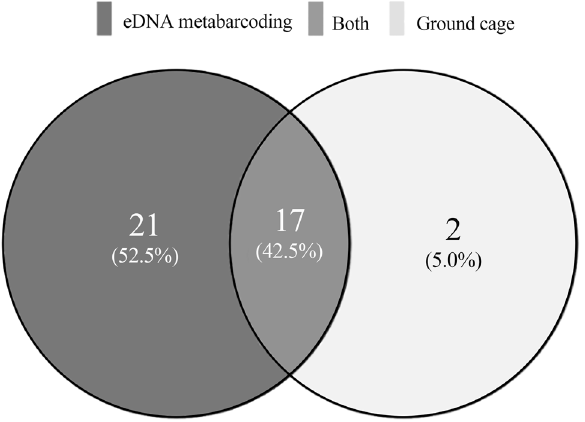
Figure 2. Number of fish species identified by eDNA (eDNA metabarcoding) metabarcoding and ground cages (17 taxa were detected by both methods, 21 taxa were detected only by eDNA, and two taxa were detected only by ground cages).